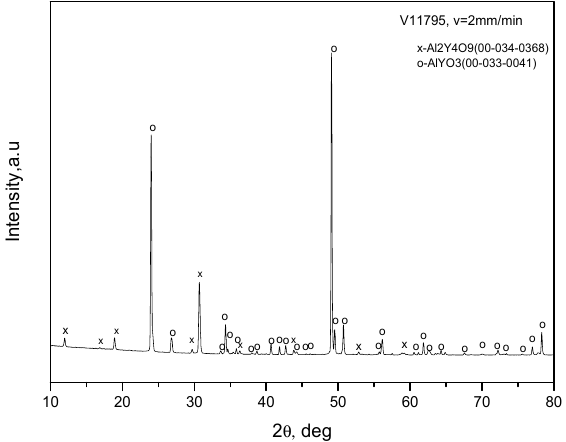
Figure 5. X-ray spectrum of the fibers crystallized at the rate of 2 mm/min. The raw oxide mixture was sintered at 1250 ° С . The microstructure of the fibers is presented in Figure 4.